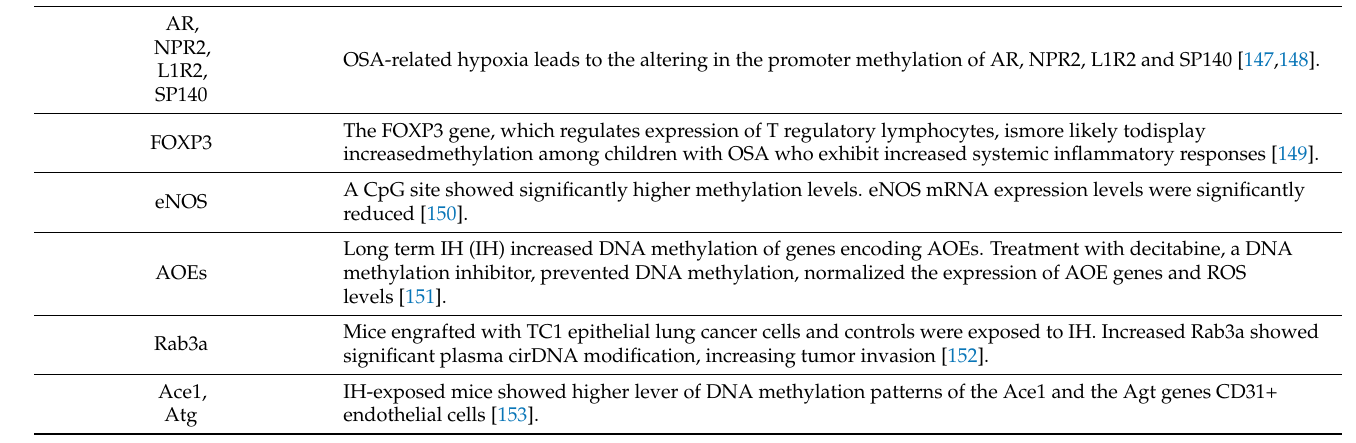
Table 4. DNA methylation in